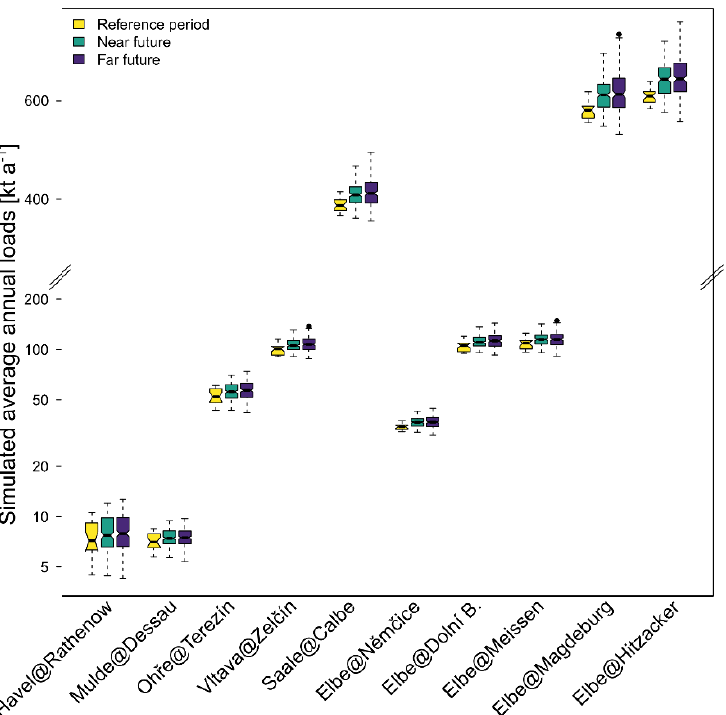
Figure 8. Boxplot of simulated average annual loads at different measurement sites along the Elbe and its tributaries. For the reference period, the range of values obtained with the 23 Pareto optimal erosion models is given, for the near and far future; all realizations of the 23 Pareto optimal solutions run with the 15th, 50th, and 85th percentile of climate models for RCP 2.6, RCP 4.5 and RCP 8.5 are represented. Note that for a better visualization, the y-axis is log scaled up to 200 kt a −1 only.